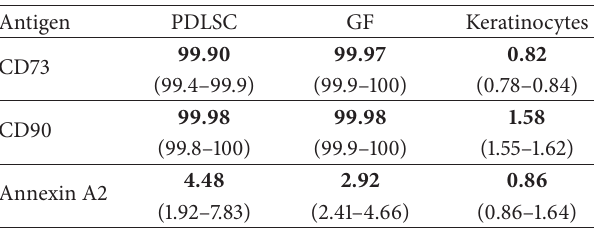
Table3:FlowcytometricanalysisofcellsurfaceexpressionofCD73, CD90, and Annexin A2. Data represent median% (range); 𝑛 = 3 replicate